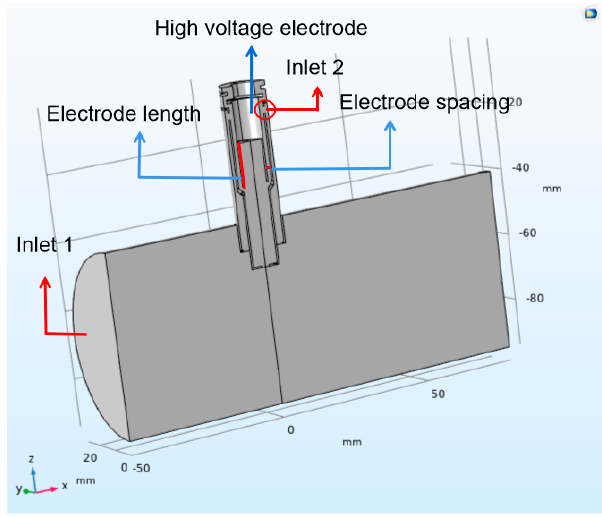
Figure 2. Model of leakage current particulate matter sensor.